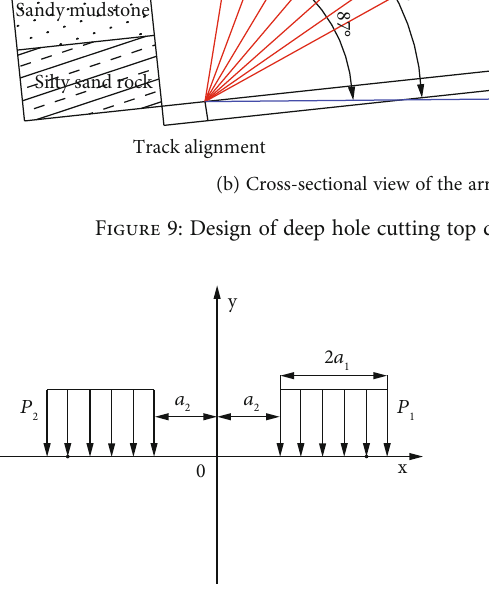
Figure 10: Basic mechanical constitutive model of an empty roadway after cutting the